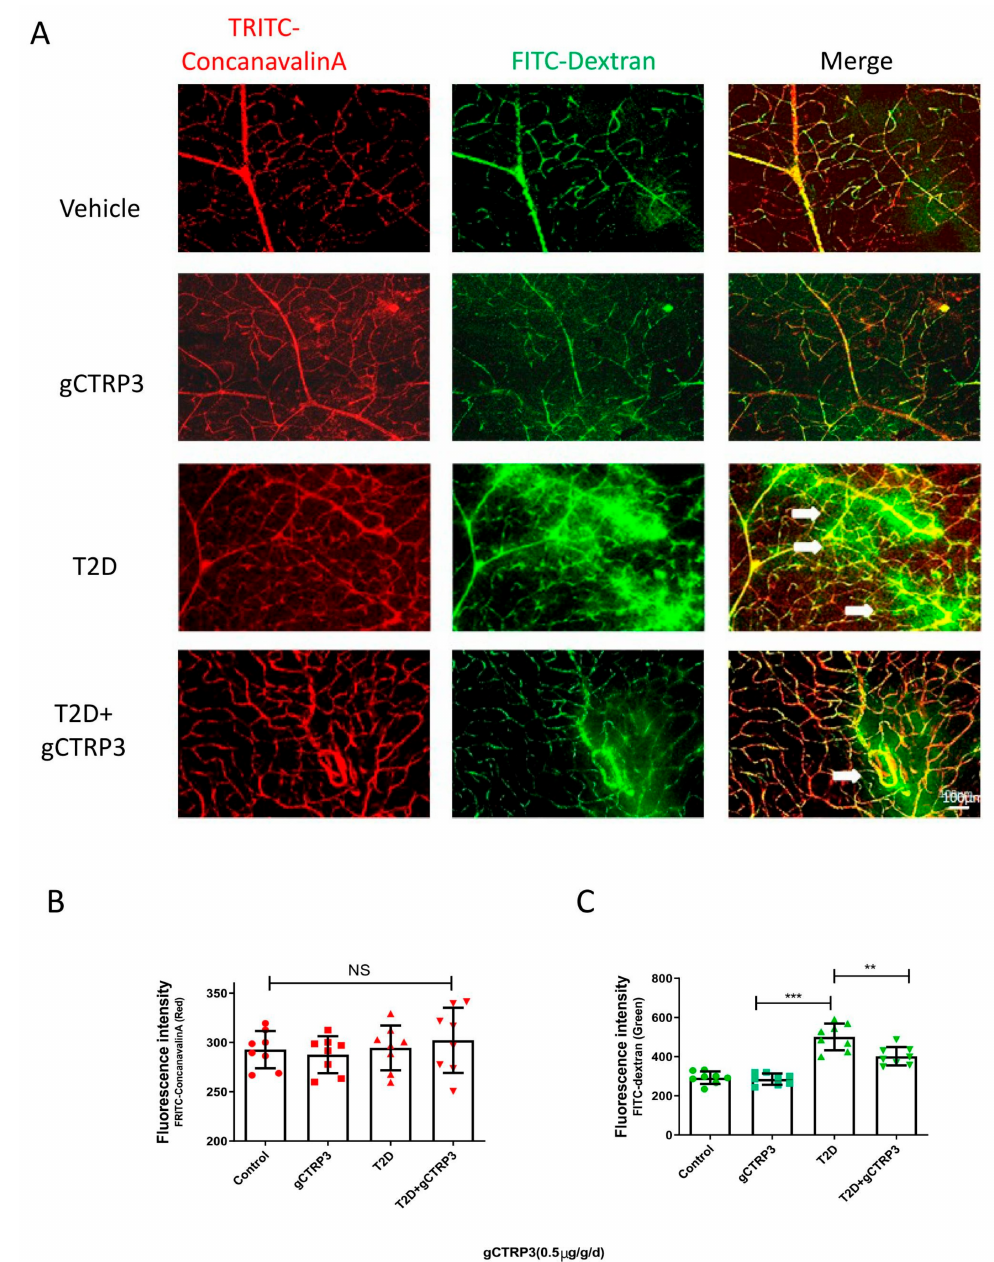
Figure 2. The protective effect of CTRP3 on DR. ( A ), Representative images showing that CTRP3 reduced the retinal vascular leakage, which was increased in the T2D DR group. ( B ), Representative images showed no visible neovascularization was evaluated with TRITC-ConcanavalinA signal (intact retinal vessels, red). ( C ), Significant extravasation of FITC-dextran (vascular leakage, green) was observed in T2D-DR mice, but it was reduced by CTRP3. All data are shown as means ± SD. n = 8–10 for each group. ** p < 0.01, *** p < 0.001; NS, not significant. White arrows indicate retinal vascular leakage. T2D, Type 2 diabetes. DR, diabetic